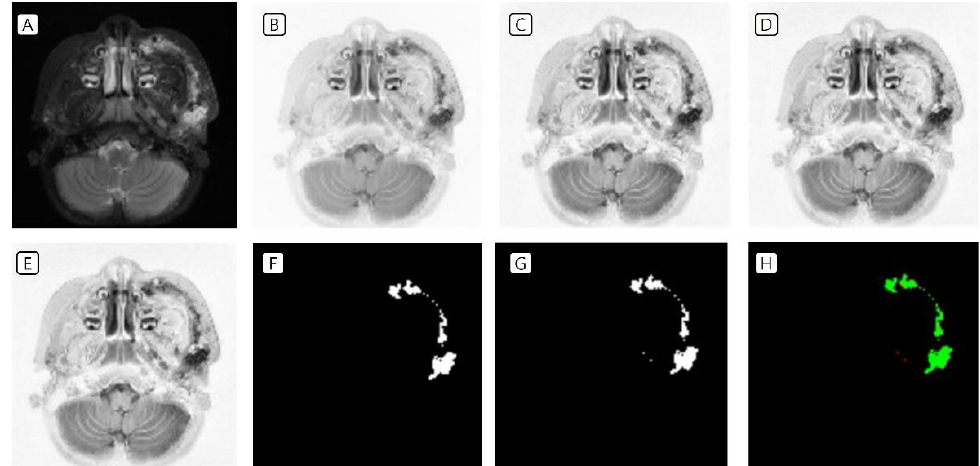
Figure 3. Another training set of VMs in the left cheek. ( A ) Resized to a volume of 16, a height of 128, and a width of 128 pixels; ( B ) inverted image; ( C ) CLAHE application; ( D ) Z-score standardization; ( E ) minimum–maximum normalization; ( F ) labeling data drawn by the clinicians; ( G ) prediction data drawn by the artificial intelligence tool; and ( H ) green indicates the matched area, while red indicates the mismatched area. VMs, venous malformations; CLAHE, contrast-limited adaptive histogram equalization.